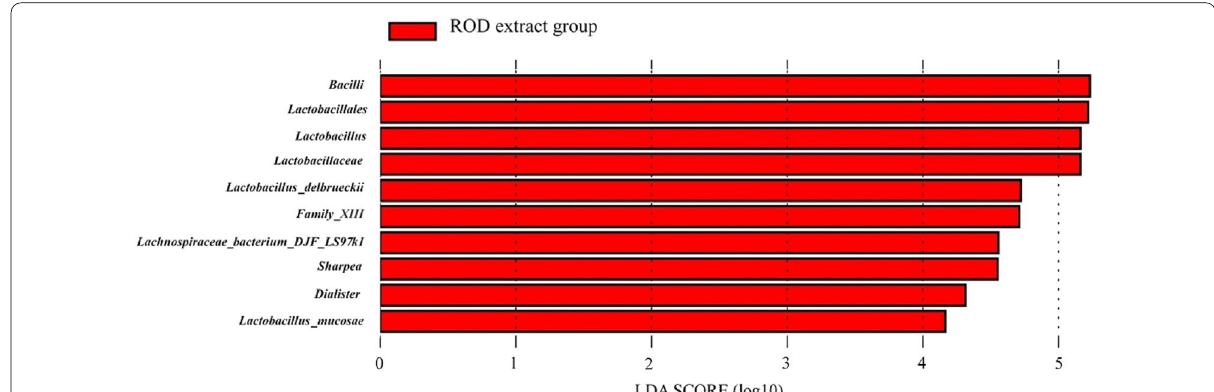
Fig. 3 Differential enrichment of bacteria due to supplementation of ROD polyphenol extract. There is not differential enrichment of bacteria in the control group, and differential enrichment of bacteria in ROD polyphenol extract group is presented with the logarithmic LDA score of 3.0 as the cutoff